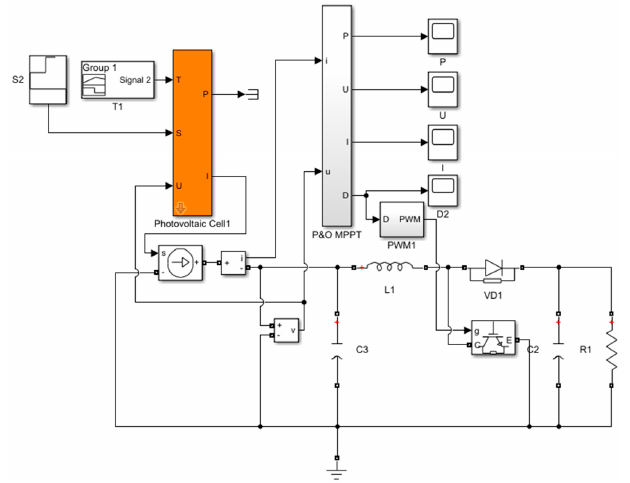
The MARLAB/Simulink model of a solar PV array with P&O control algorithm is shown in Figure 15 to illustrate its performance characteristics at different illumination and cell temperatures. The Simulink model shown in Figure 14 was developed for the specifications listed in Tables 1 and 2. Table 2. Main parameters of DC–DC boost converter.